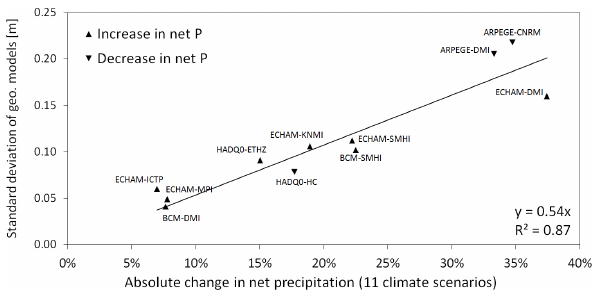
Figure 5. Standard deviations of the change in hydraulic head from the geological models (Table 3), compared with the change in the reference net precipitation ( P − ET ref )